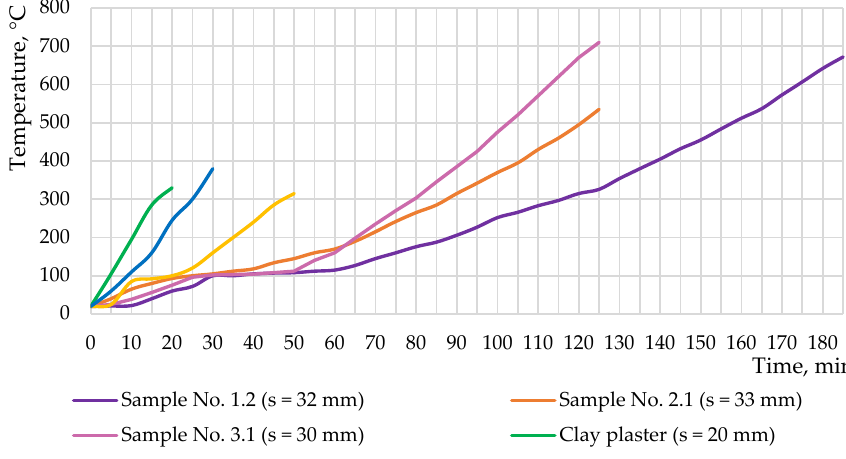
Figure 15 . Experimental temperature curves of samples covered with plaster compositions.